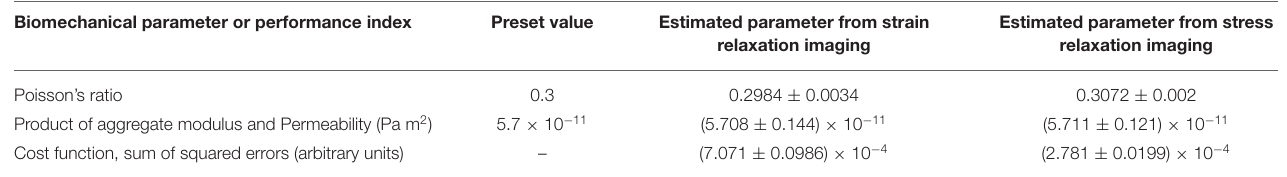
TABLE 2 | The performance of the inverse method was tested by using the strain data generated from FEM simulation of a poroelastic phantom undergoing a stress or strain relaxation compression, with predefined biomechanical properties.